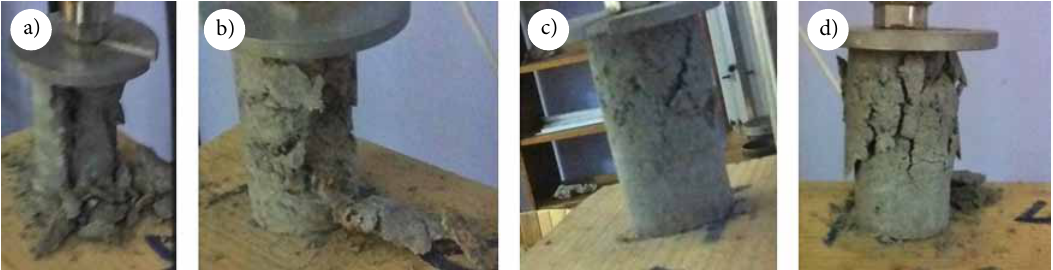
Fig. 4. Compressed specimens: a – no additives (sand soil), b – no additives (clay soil), c – containing fly ash (sand soil), d – containing fly ash